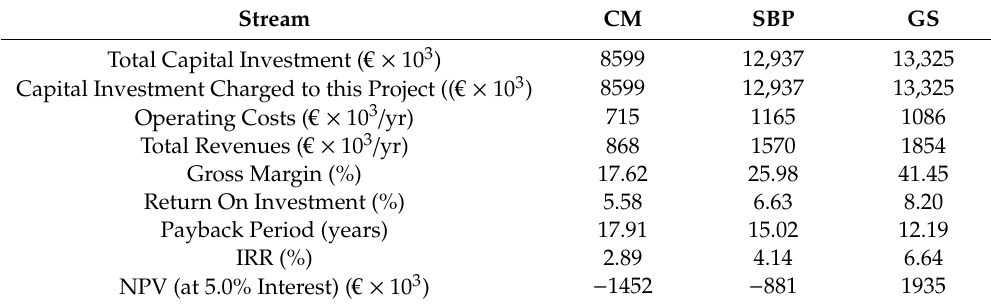
Table 16. Viability of biogas power plant including subsidy.